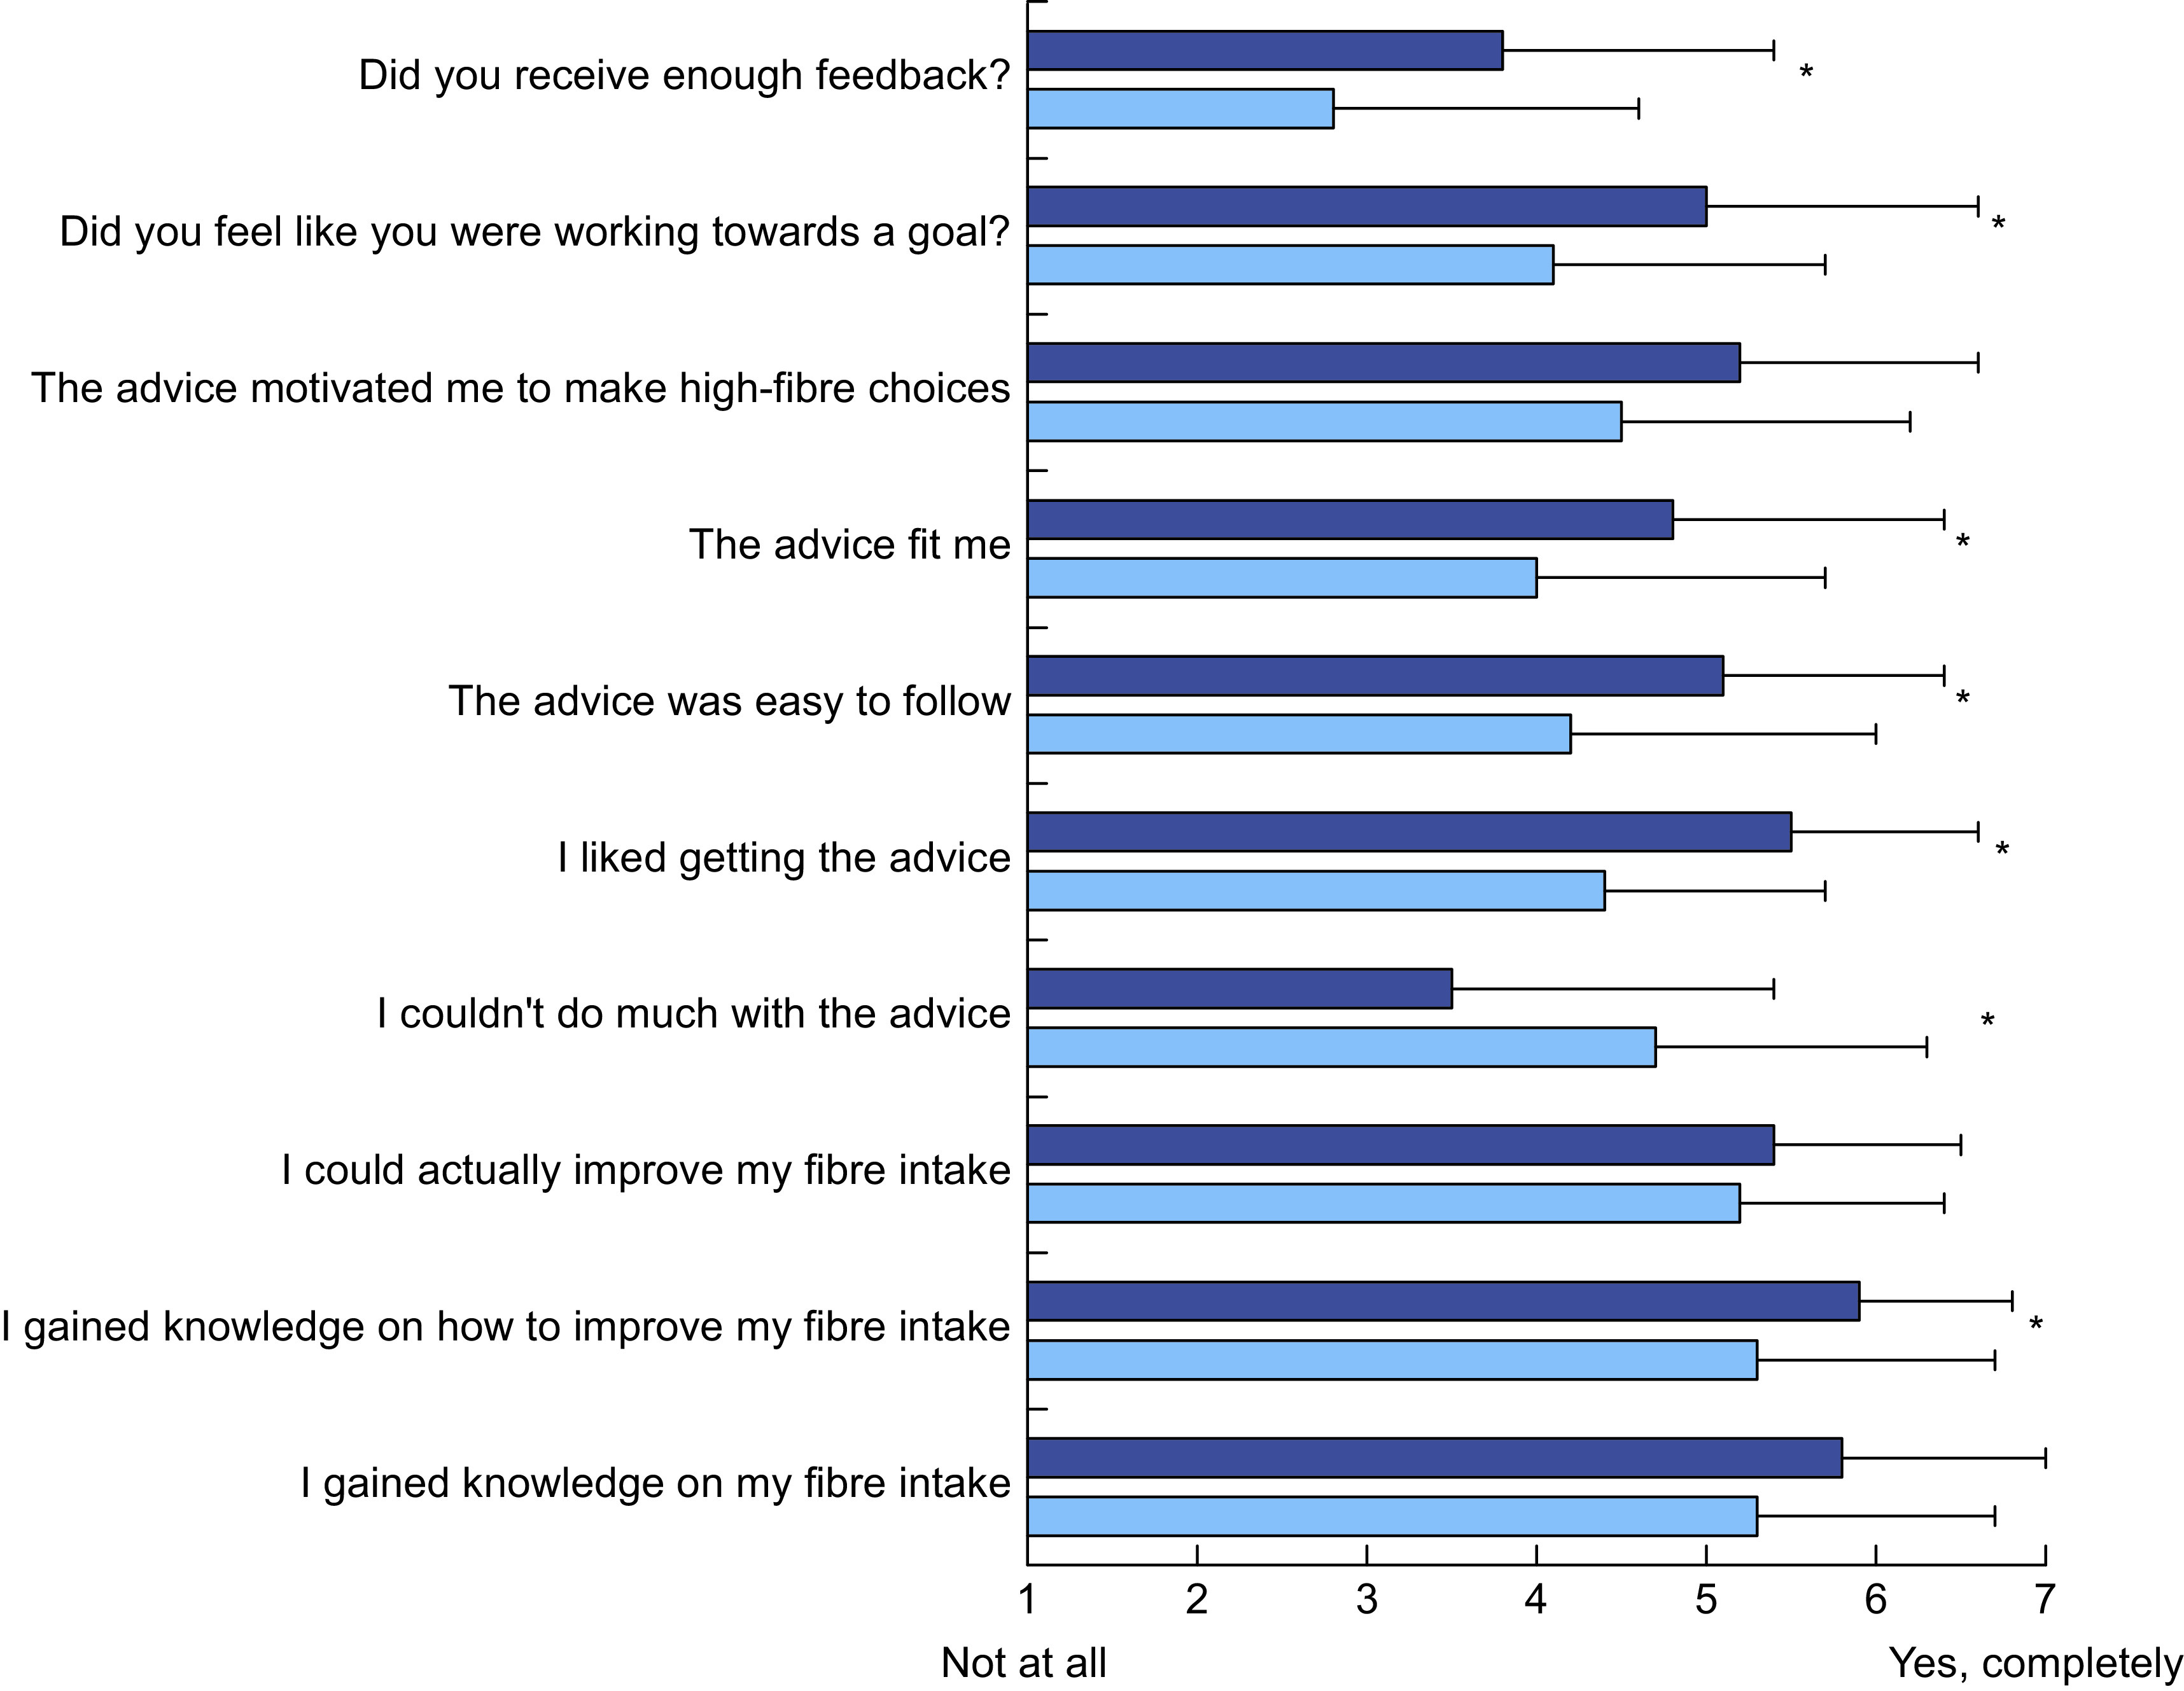
Intervention group rated the advice significantly better than the general advice (GA) group. The questionnaire was performed after the 6-week intervention. Statements were rated on a seven-point Likert scale. Error bars represent the standard deviation. , Personalised dietary advice (PDA) (n
34);
, GA (n 47)